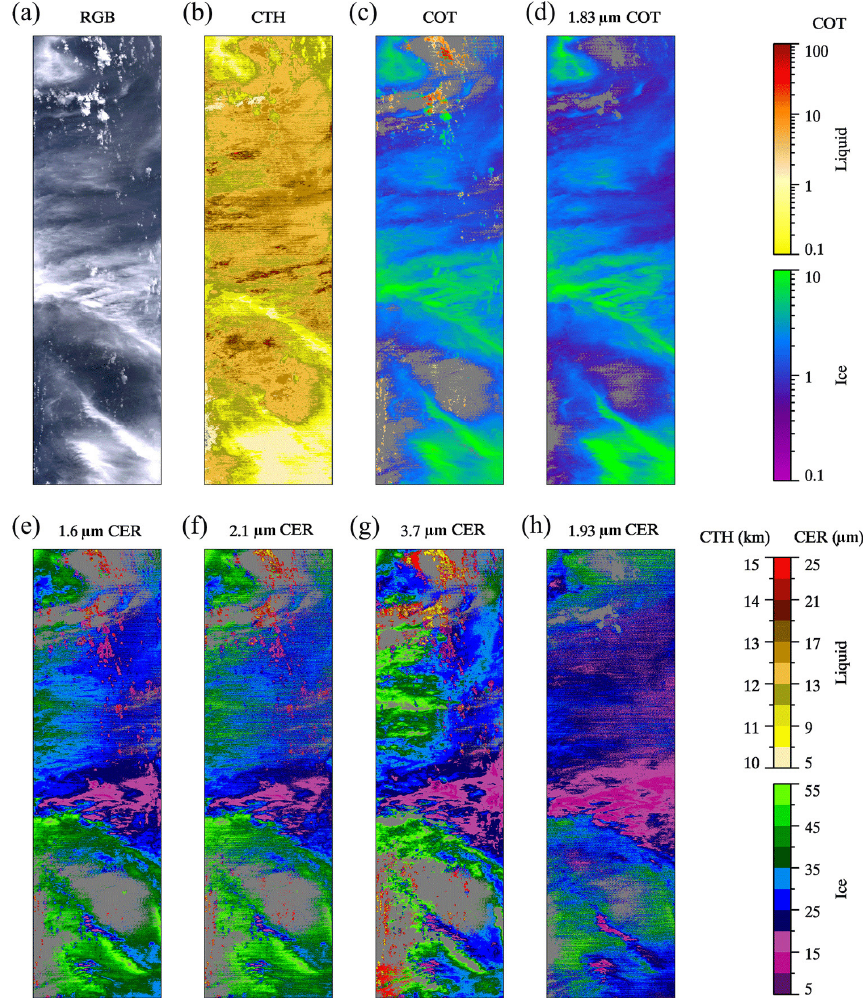
Figure 4. eMAS CTH, COT, and CER retrievals for a portion of track 8 of the 18 September 2013 SEAC 4 RS science flight. The direction of travel of the ER-2 is from top to bottom in each panel. (a) True color RGB